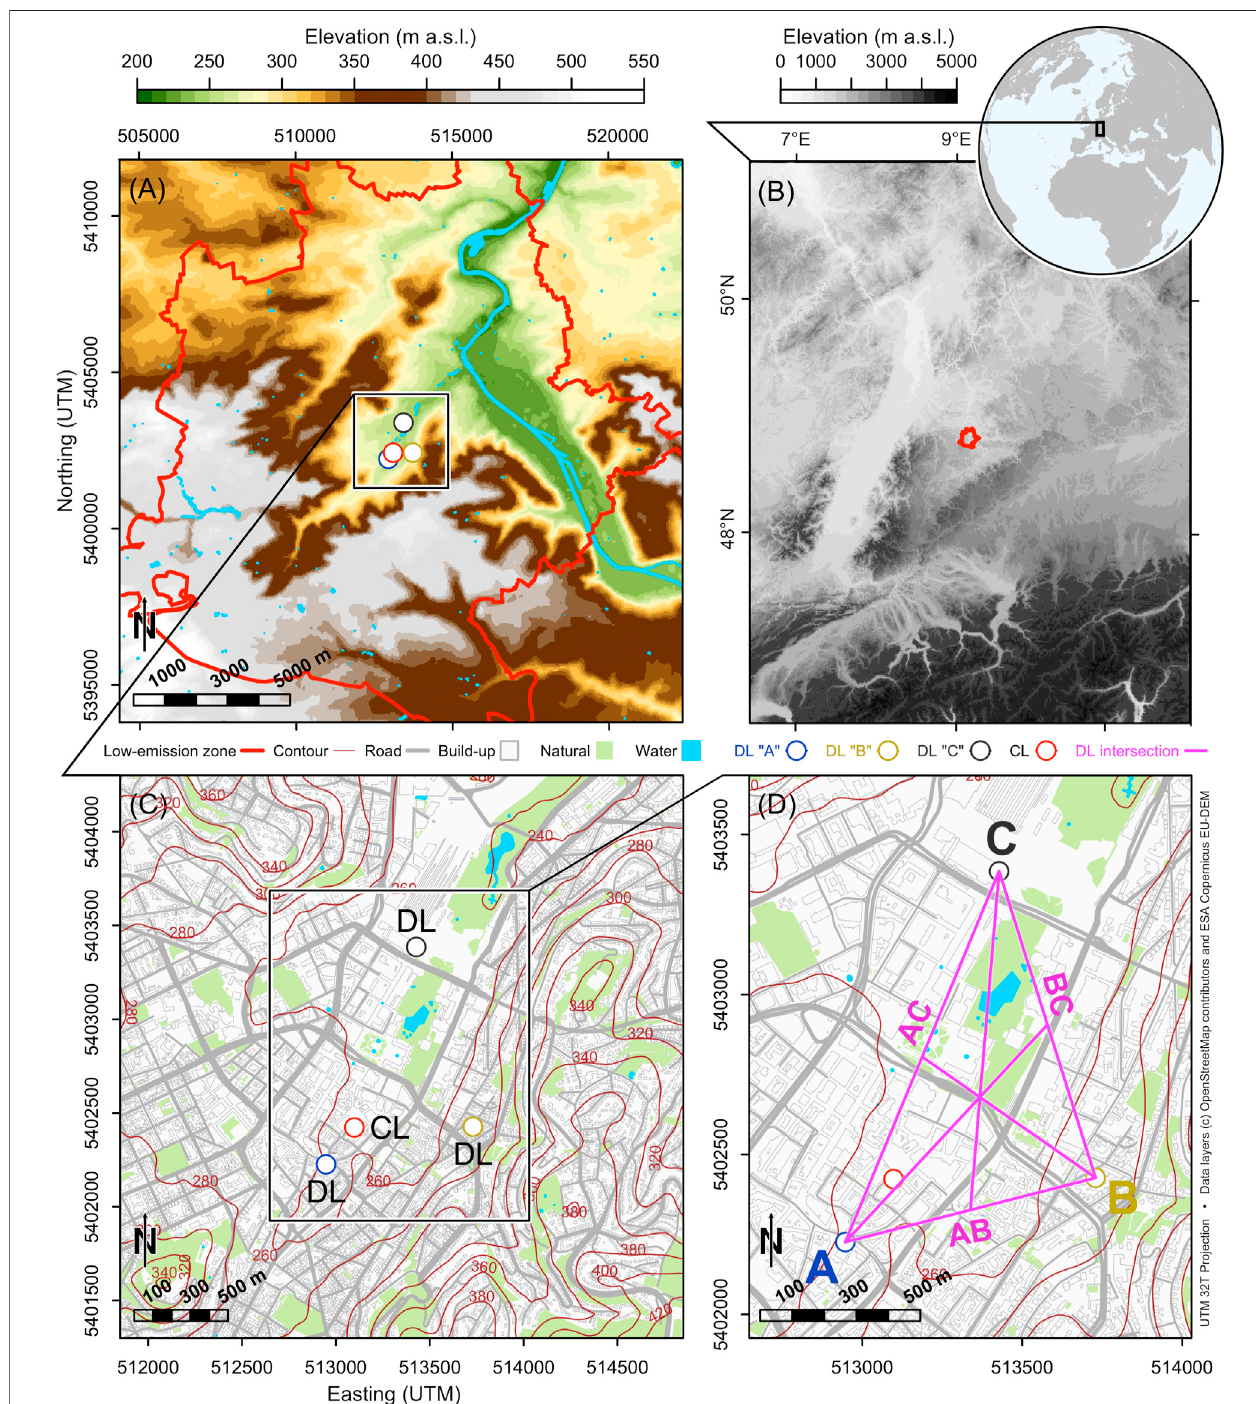
FIGURE 1 | Situation of Stuttgart, Germany, showing (A) the local topography, (B) the complex regional topography, and (C,D) the locations of Doppler lidar (DL) and ceilometer (CL) systems in the City Centre. Except for (B) , the coordinates are shown in UTM projection.